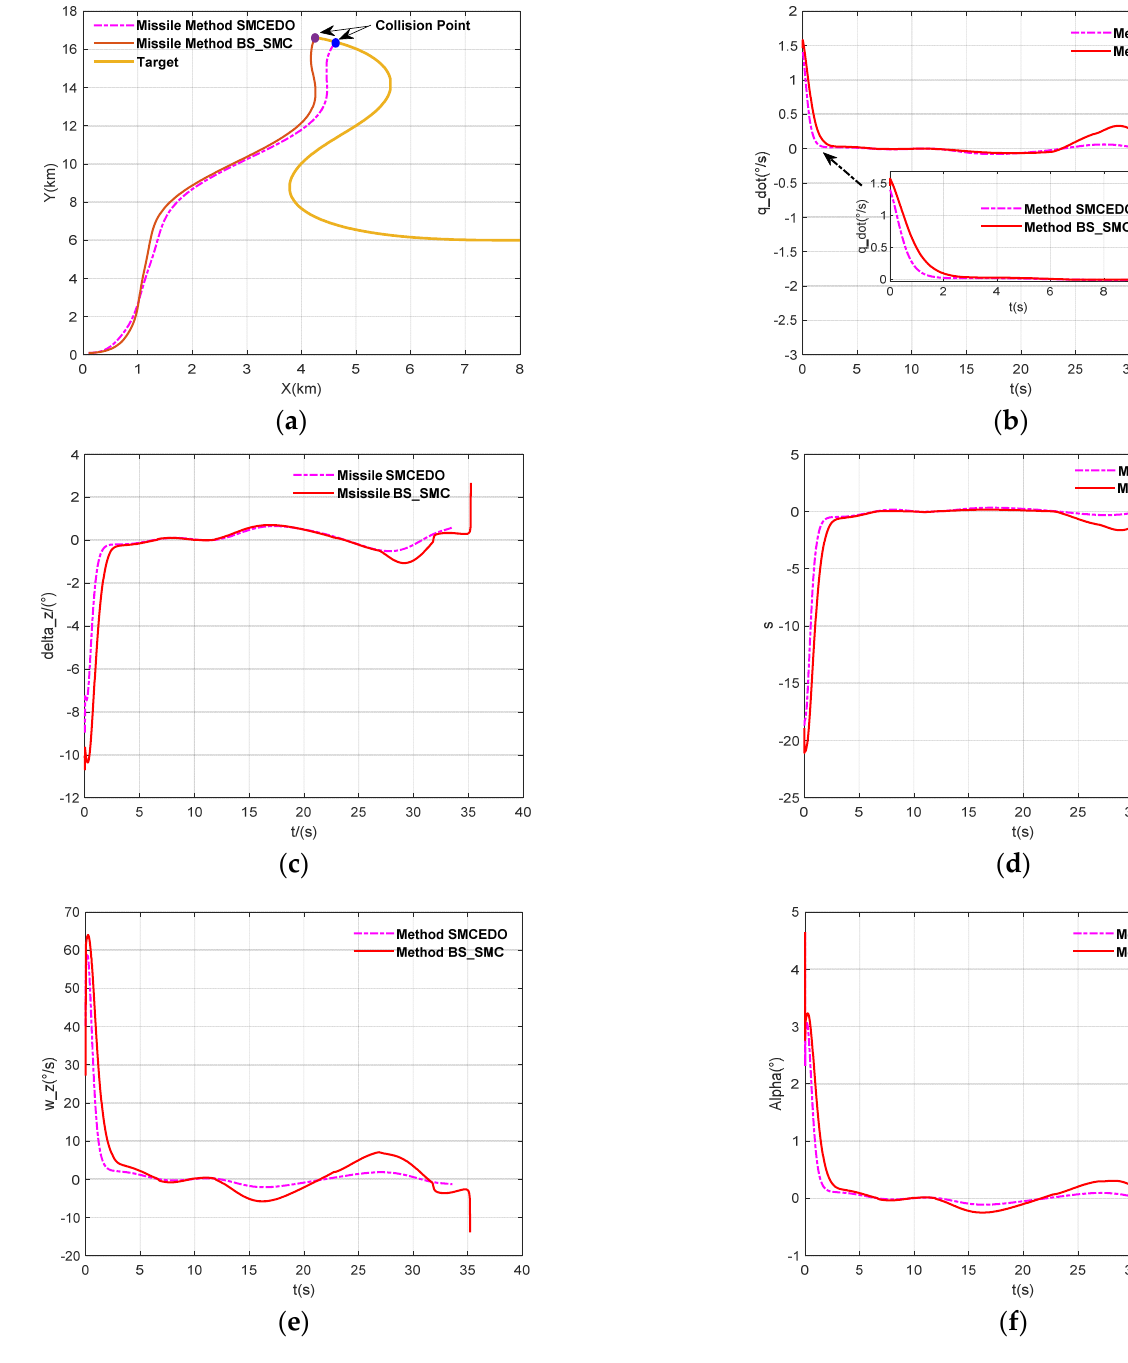
Figure 7. ( a ) Missile–Target pursuit trajectory; ( b ) The curve of the LOS angular rate; ( c ) The curve of the rudder deflection; ( d ) The curve of the sliding mode surface; ( e ) The curve of the pitch angular rate; ( f ) The curve of the attack angle.